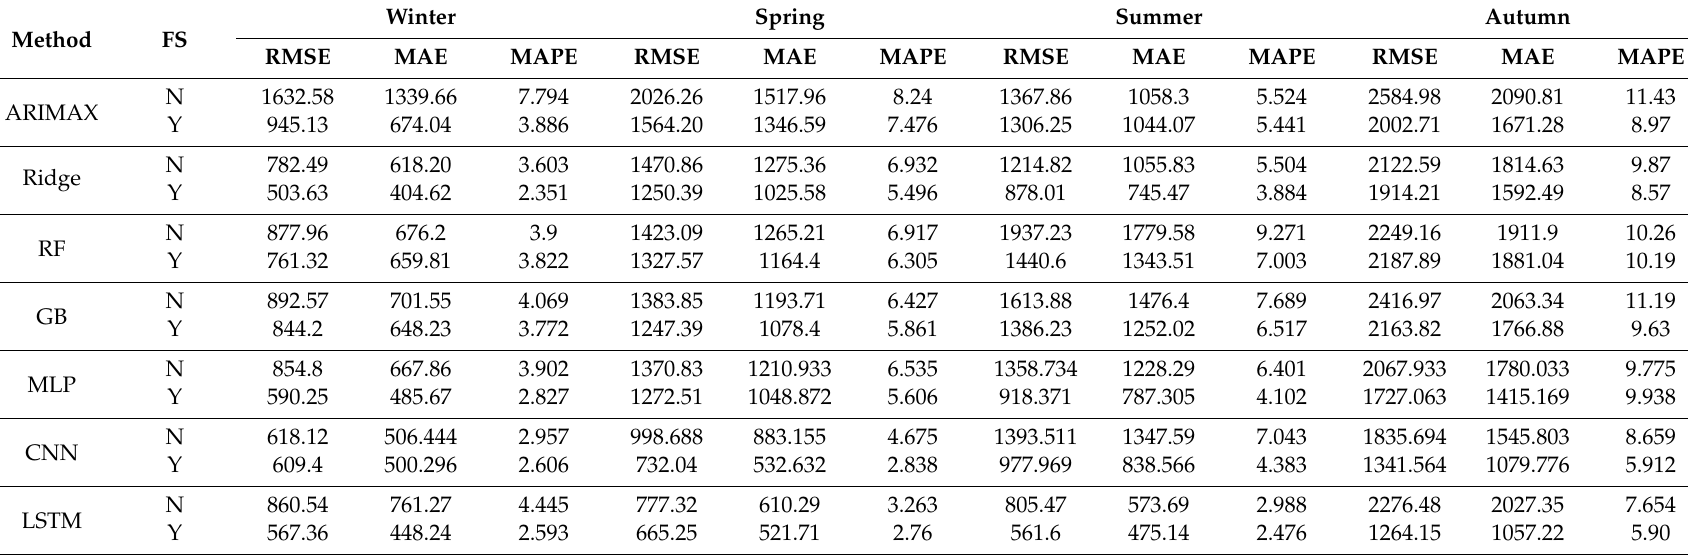
Table 9. Error rates of seasonal